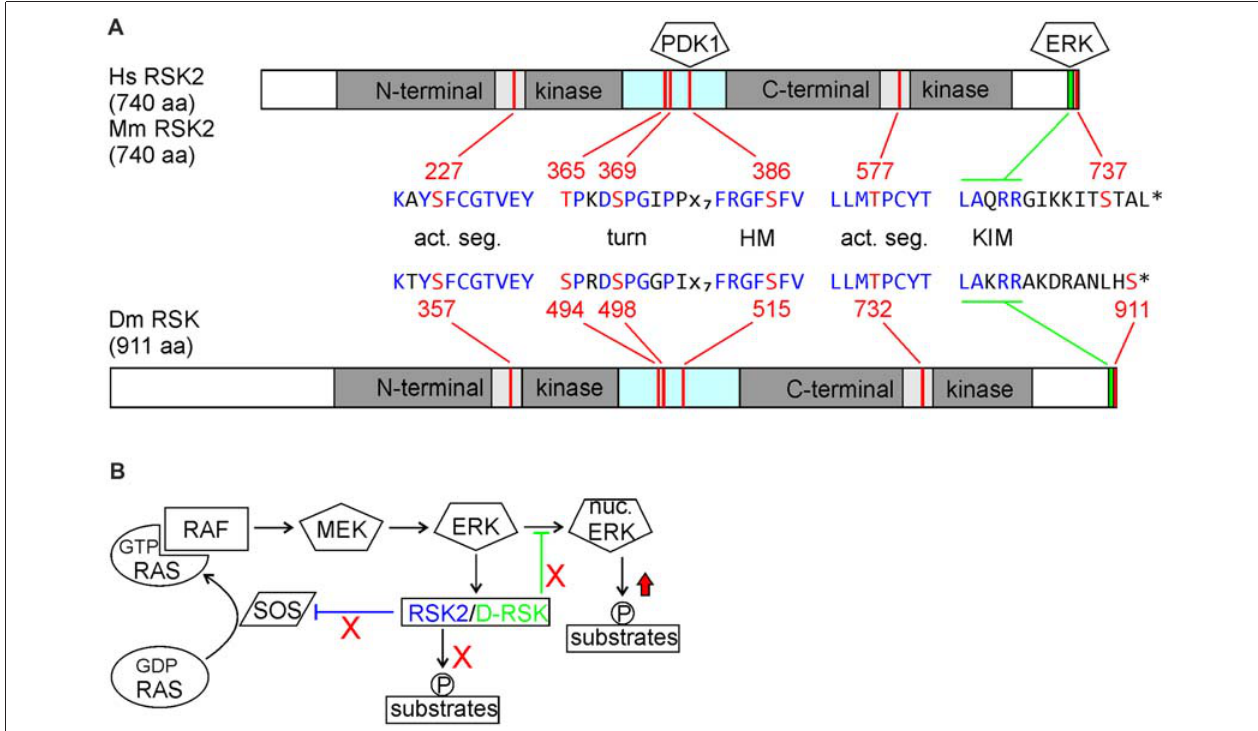
FIGURE 1 | (A) Comparison of human and mouse ribosomal S6 kinase 2 (RSK2) with Drosophila D-RSK. Conservation of all relevant phosphorylation sites (red) embedded in common consensus sequences (blue) indicates a common mode of activation. Activated ERK binds to the C-terminal kinase interaction motif (KIM) and induces catalytic activity of the C-terminal kinase domain (CTKD) by phosphorylation of a threonine residue (RSK2: T577; D-RSK: T732) in the kinase activation segment. The CTKD in turn phosphorylates a serine residue (RSK2: S386; D-RSK: S515) in the hydrophobic motif (HM) located in the linker region, which promotes binding and activation of 3-phosphoinositde-dependent kinase 1 (PDK1). Furthermore, ERK phosphorylates two residues (RSK2: T365, S369; D-RSK: S494, S498) in the turn motif next to the N-terminal kinase domain (NTKD). In combination with PDK1-mediated phosphorylation of serine S227 (D-RSK: S357) this stabilizes the active conformation of the NTKD, as shown for other AGC-type kinases (Leroux et al., 2018). Involvement of Drosophila PDK1 in D-RSK activation was deduced from genetic interaction studies (Rintelen et al., 2001). Release of ERK is promoted by NTKD-mediated autophosphorylation of serine 737. Whether the corresponding C-terminal serine residue 911 in D-RSK has a similar function is not known. (B) Integration of RSK2 and D-RSK in MAP-kinase signaling. Loss-of-function mutations not only abolish phosphorylation of RSK substrate proteins but also prevent feedback inhibition (red crosses) resulting in enhanced ERK-mediated phosphorylation of substrate proteins (red arrow). Different mechanisms for negative regulation of ERK by RSK2 (inhibition of RAS activation) or D-RSK (inhibition of ERK nuclear translocation) have been described.